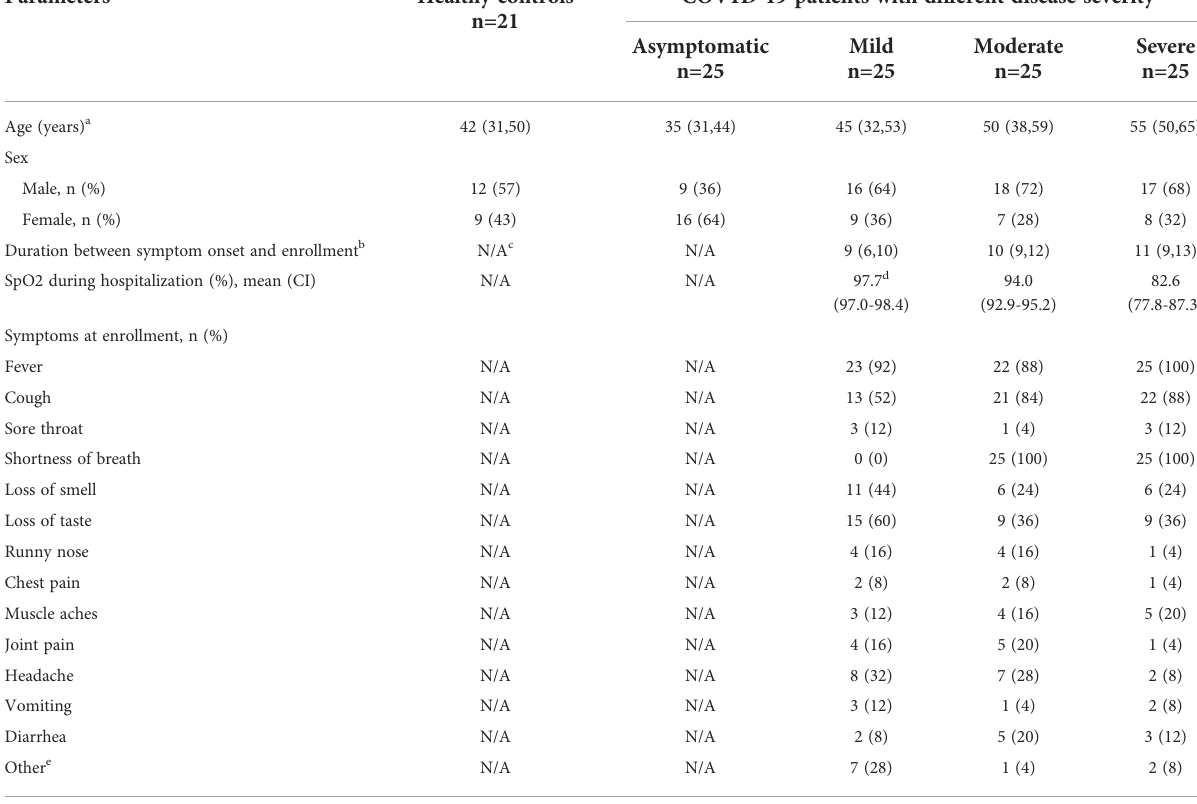
TABLE 1 Demographic information for the study participants.